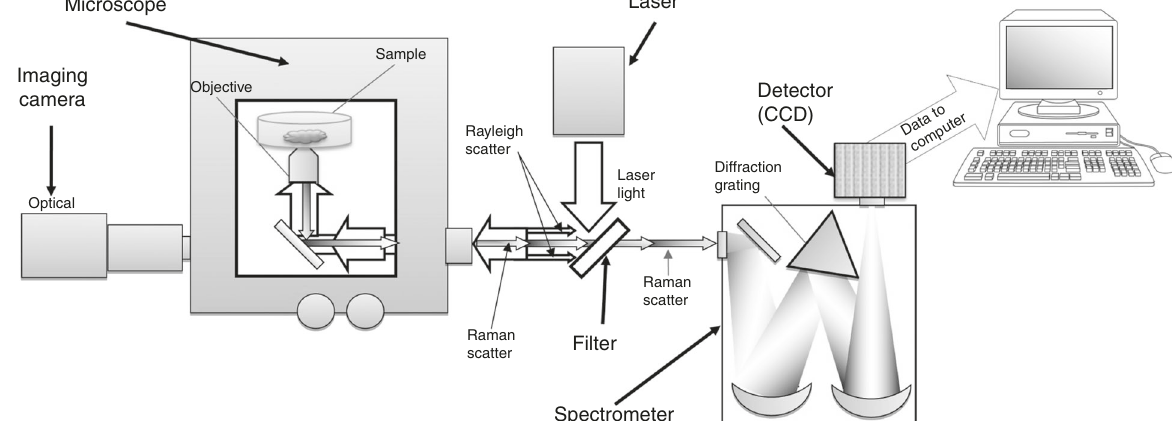
Fig. 4 Simpli fi ed schematic of a Raman system. Reprinted by permission from Springer Nature Customer Service Center GmbH: Springer Nature. Springer eBook, Raman Micro-Spectroscopy as a Noninvasive Cell Viability Test, Verrier S. et al. © 2011